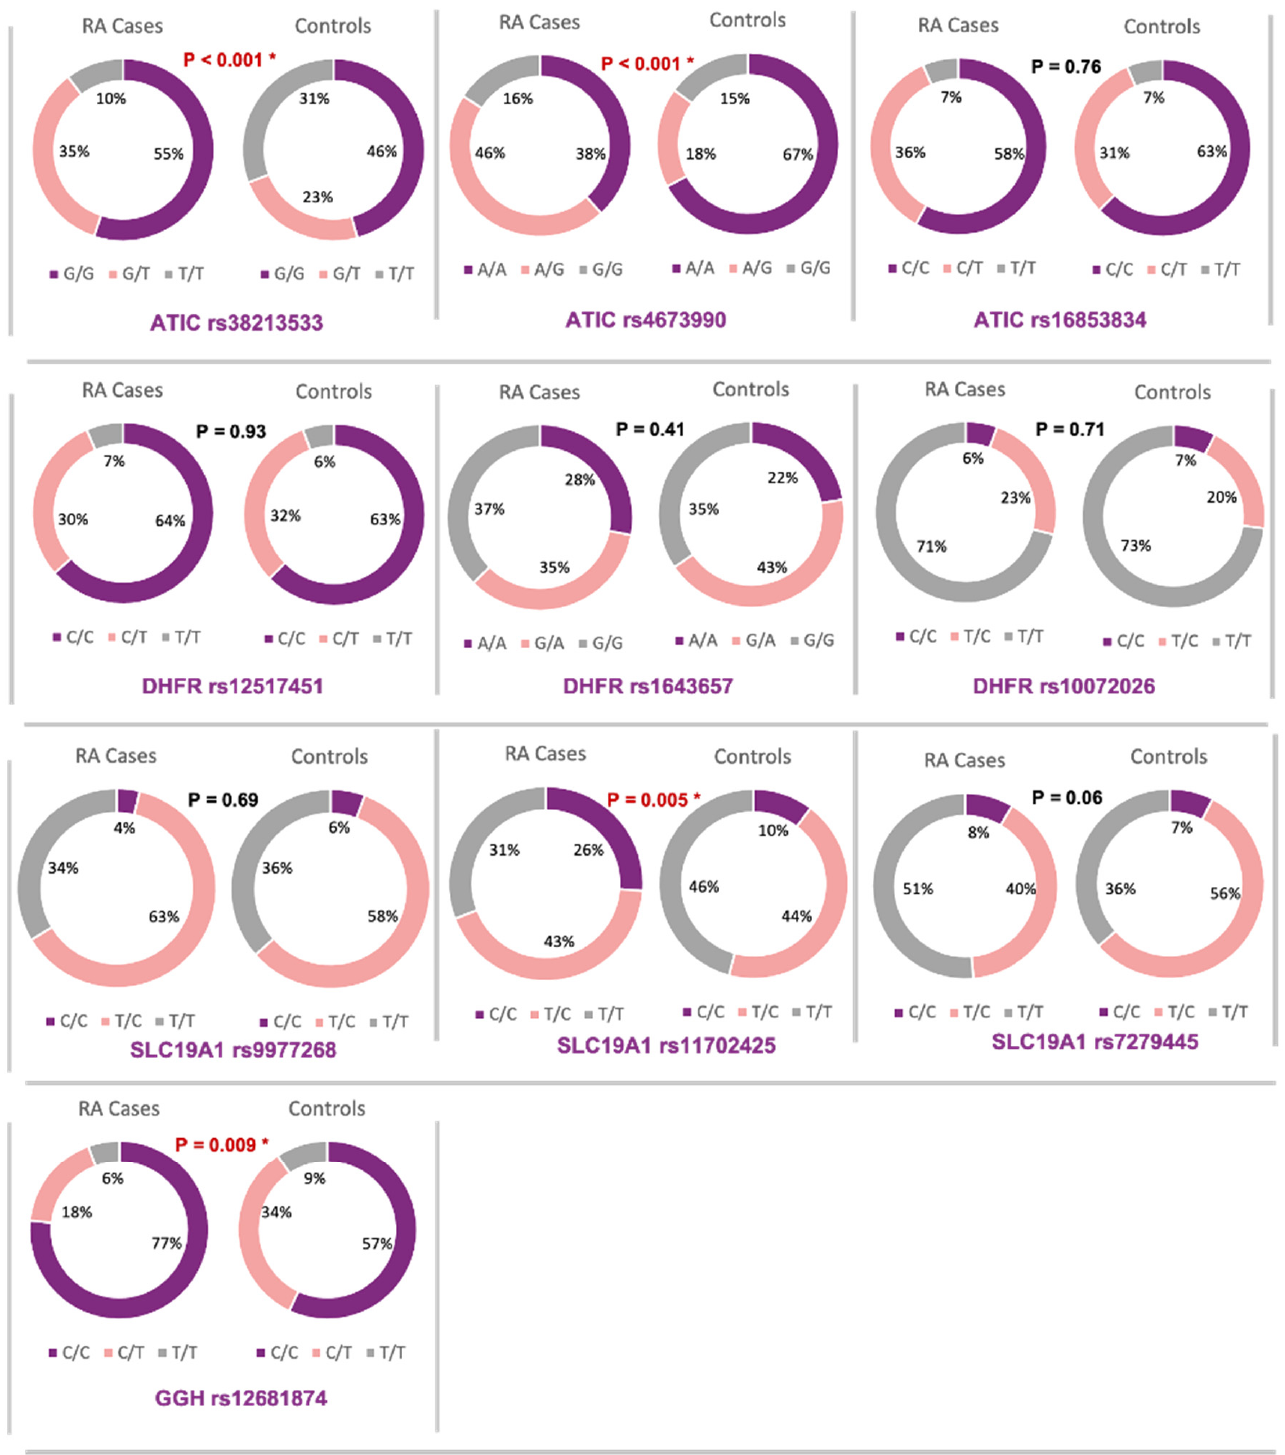
Figure 1. Genotype frequencies of methotrexate pathway genes in rheumatoid arthritis versus normal controls. * p -value < 0.05 and statistically significant.